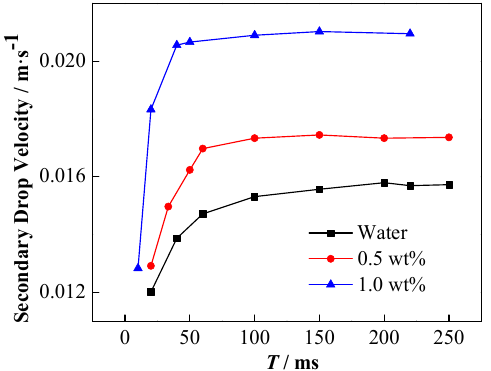
Figure 16. Change of the rising speed of secondary droplets with time under different NP concentration conditions, electric field strength is 256 kV·m −1 .